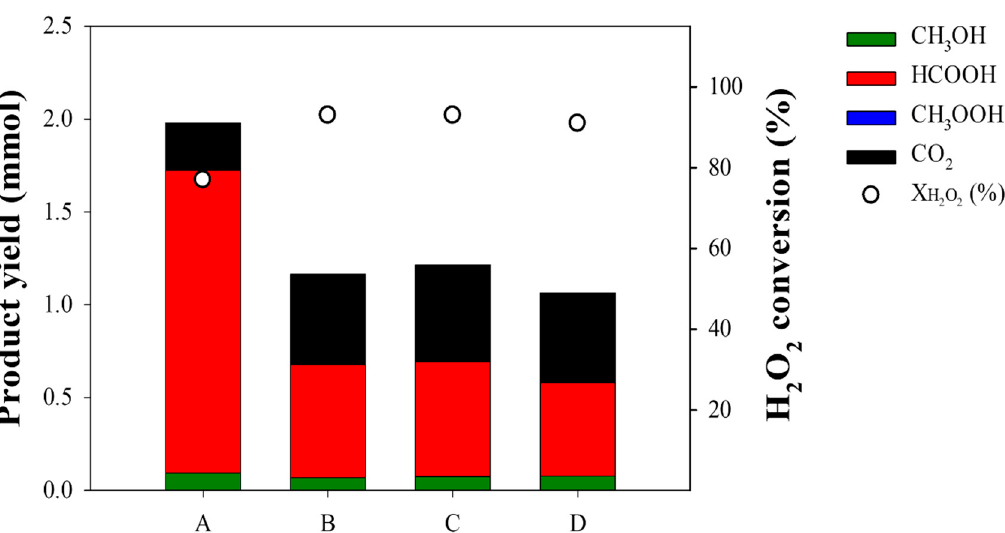
Figure 6. Partial oxidation of methane over 0.51%Fe/ZSM-5(IE) (A), 0.51%Fe/ZSM-5(IE) + Cu(CH 3 COO) 2 (B), 0.51%Fe/ZSM-5(IE) + Cu(NO 3 ) 2 (C), and 0.51%Fe/ZSM-5(IE) + CuSO 4 (D). Reaction conditions: 50 mg catalyst, [Cu] = 0.147 mM, 31 bar methane, 0.277 M H 2 O 2 , liquid volume = 30 mL, reaction temperature = 50 °C.